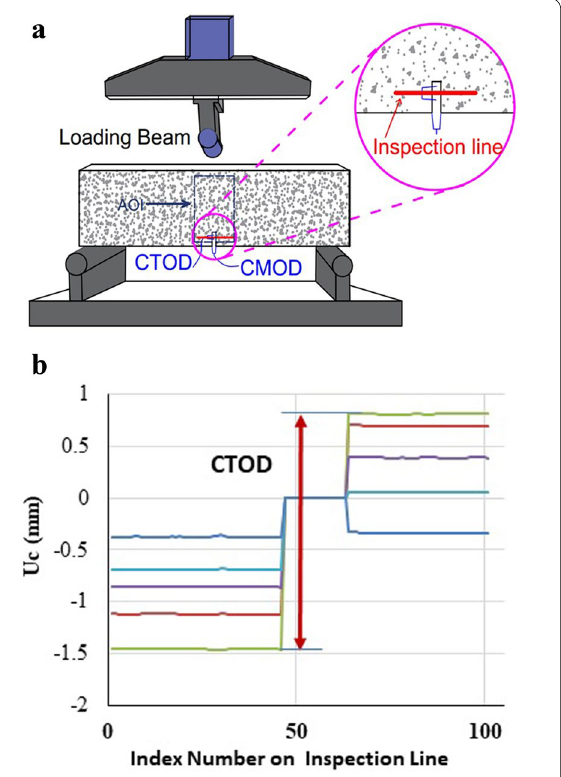
Fig. 6 DIC setup and crack-width calculation: a DIC setup; b illustration of COD calculation using Uc variation on an inspection line at different